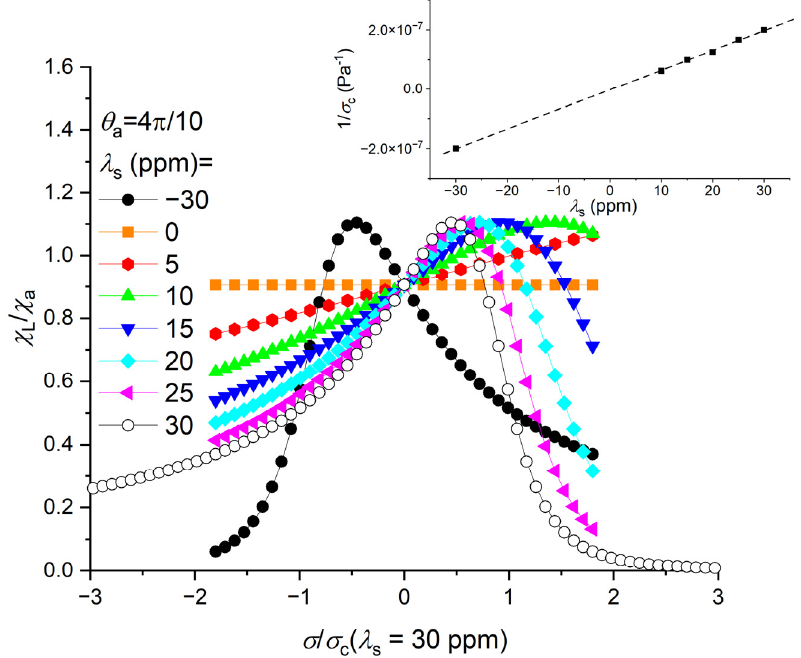
Figure 7. Relative susceptibility components ( χ L / χ a ) versus stress σ for different magnetostriction constant λ s . The inset shows the inverse of the critical stress σ c versus magnetostriction constant λ s and dashed line is a guideline.